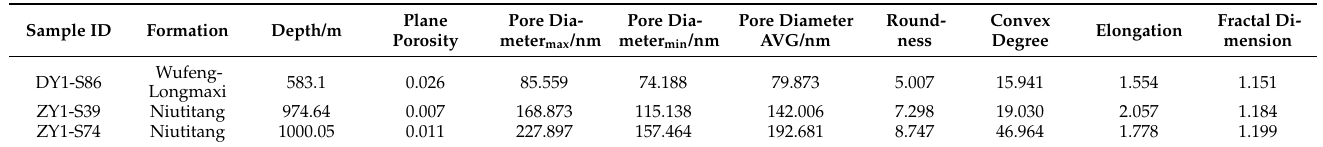
Figure 8. Organic matter pores in the shales of the Wufeng-Longmaxi Formation and Niutitang Formation in northern Guizhou Province. ( a ) DY1-S86 of the Wufeng-Longmaxi Formation; ( b ) ZY1- S39 of the Niutitang Formation; ( c ) ZY1-S74 of the Niutitang Formation; ( d ) DY1-S86 organic matter pore extraction of the Wufeng-Longmaxi Formation; ( e ) ZY1-S39 organic matter pore extraction of the Niutitang Formation; ( f ) ZY1-S74 organic matter pore extraction of the Niutitang Formation. Table 9. Organic matter pore morphology parameters of shale in the Wufeng-Longmaxi and Niutitang Formations in northern Guizhou